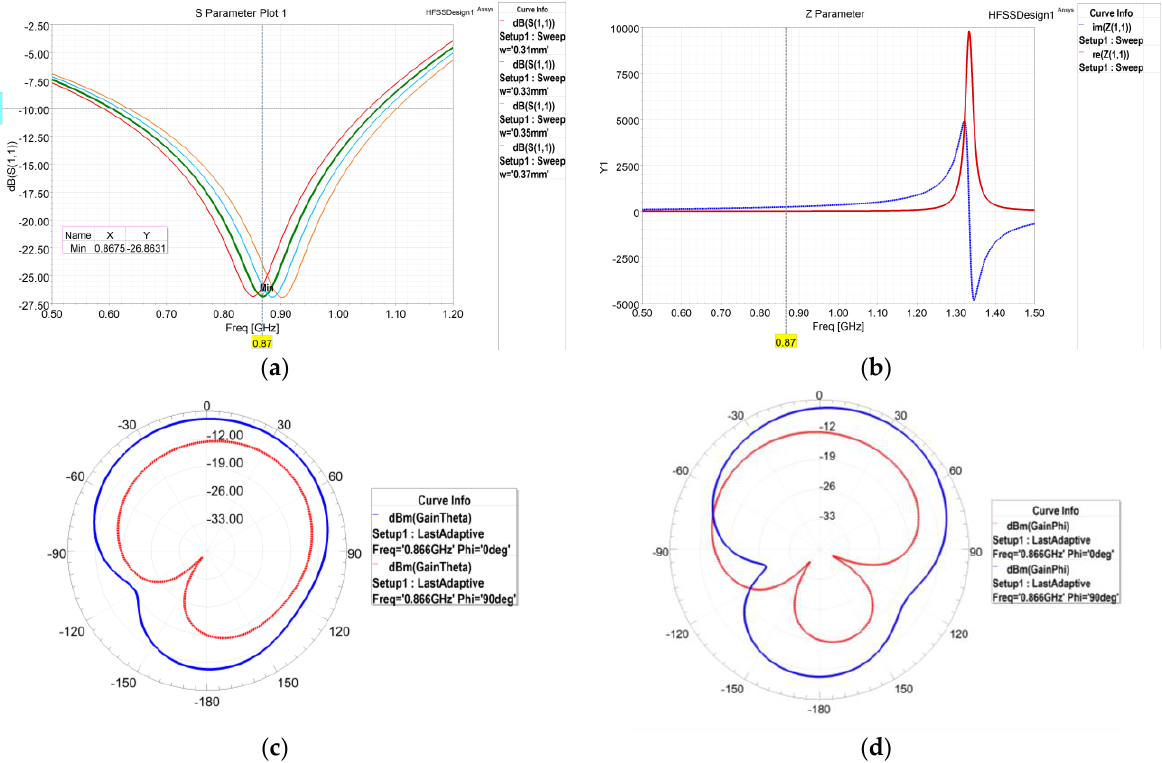
Figure 7. ( a ) Frequency tuning by sweeping W parameter; ( b ) antenna input impedance; ( c ) co-and cross-polarization of E plane (XZ plane); ( d ) co-and cross-polarization of H plane (YZ plane).